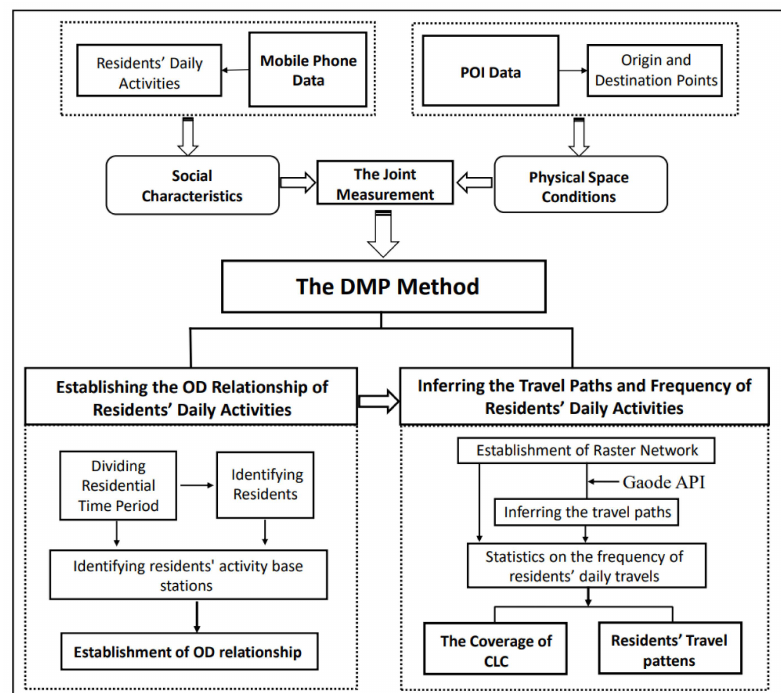
Figure 1. Flowchart of the DMP